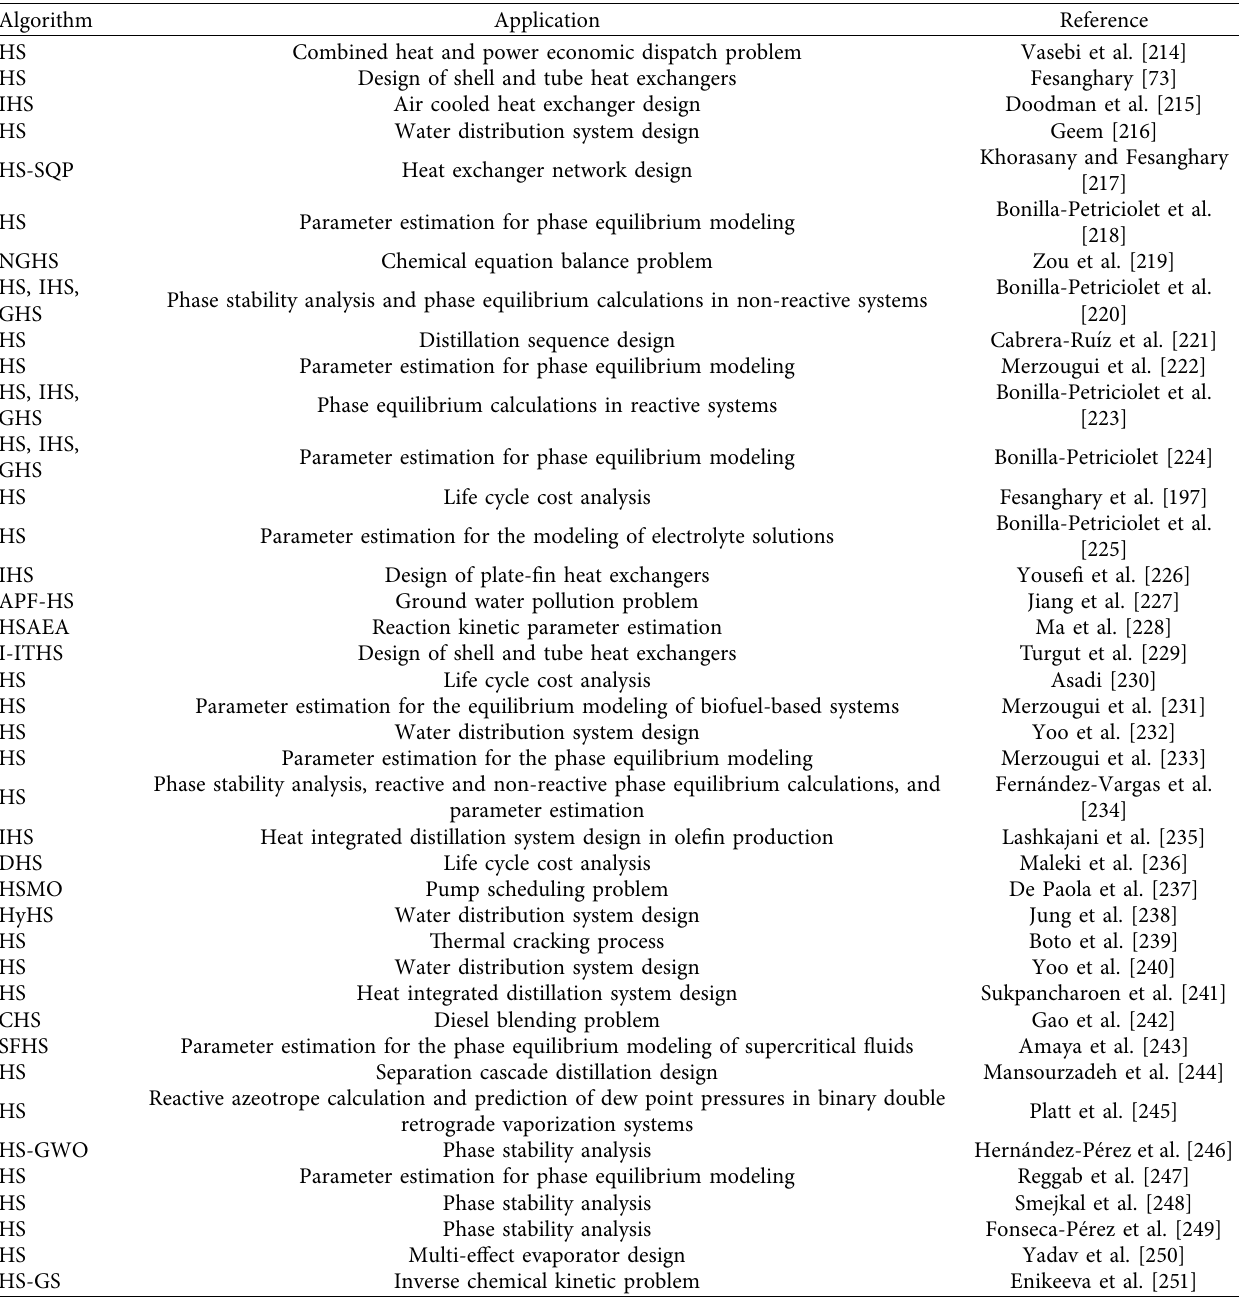
Table 6: Harmony search applications in chemical engineering